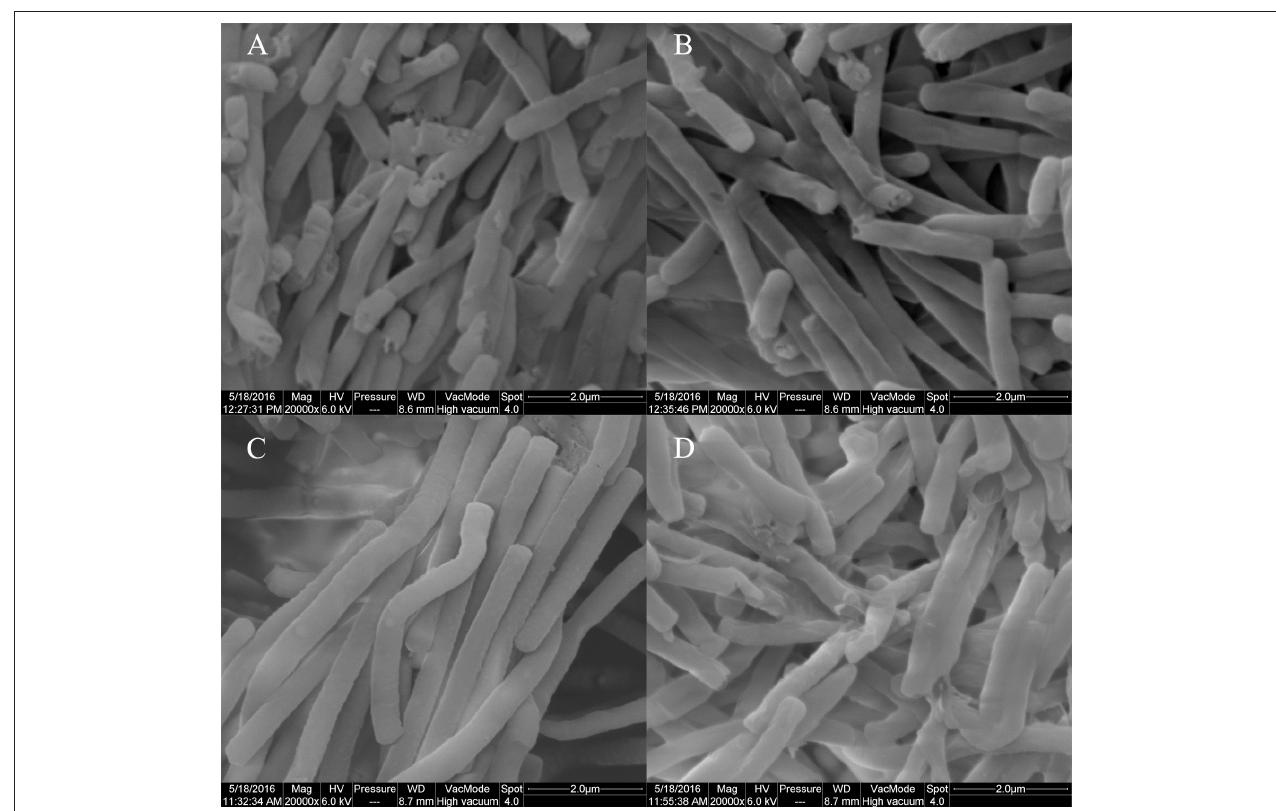
FIGURE 10 | Results of electron microscopy (20000 × ). (A) :BAA-365; (B) : 1 H4160-1; (C) : 1 H0115-1; (D) : r 1 H0115-1.